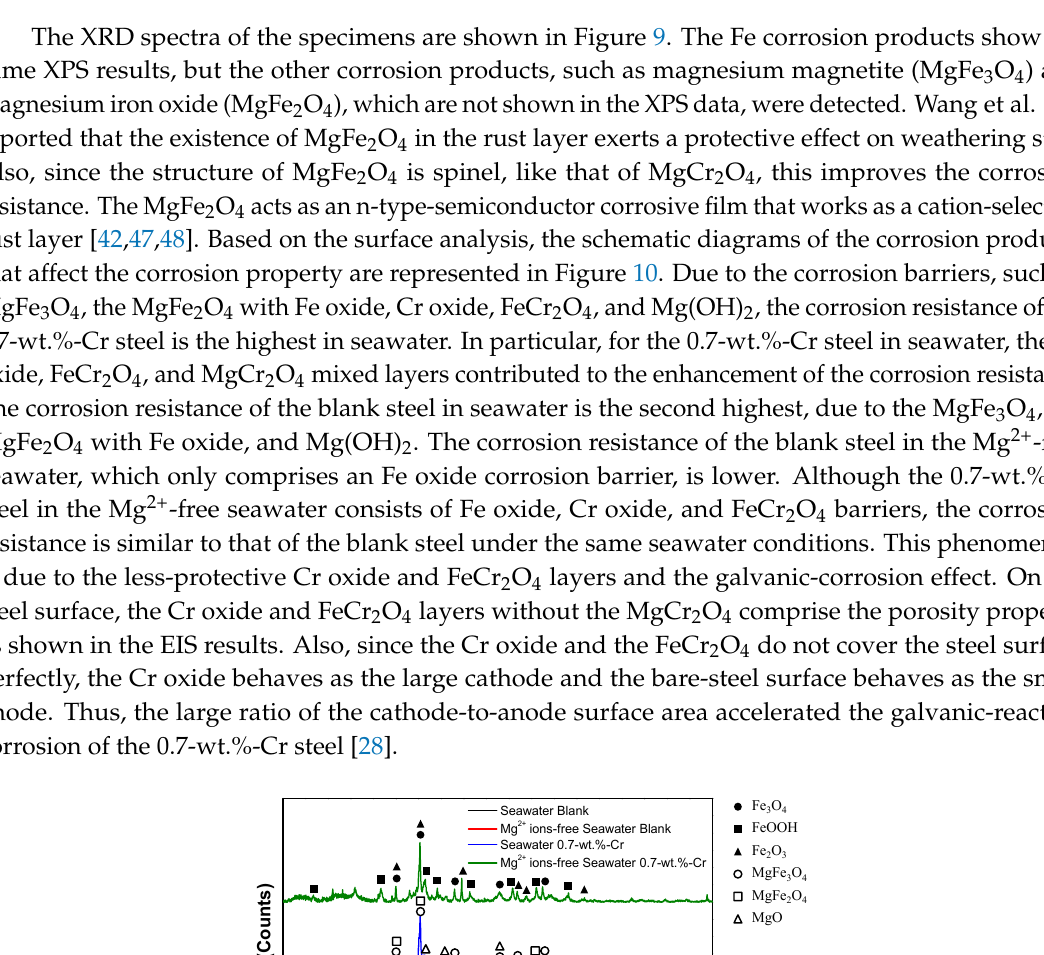
Table 2. Analysis of the XPS peaks for the surface of the specimens.